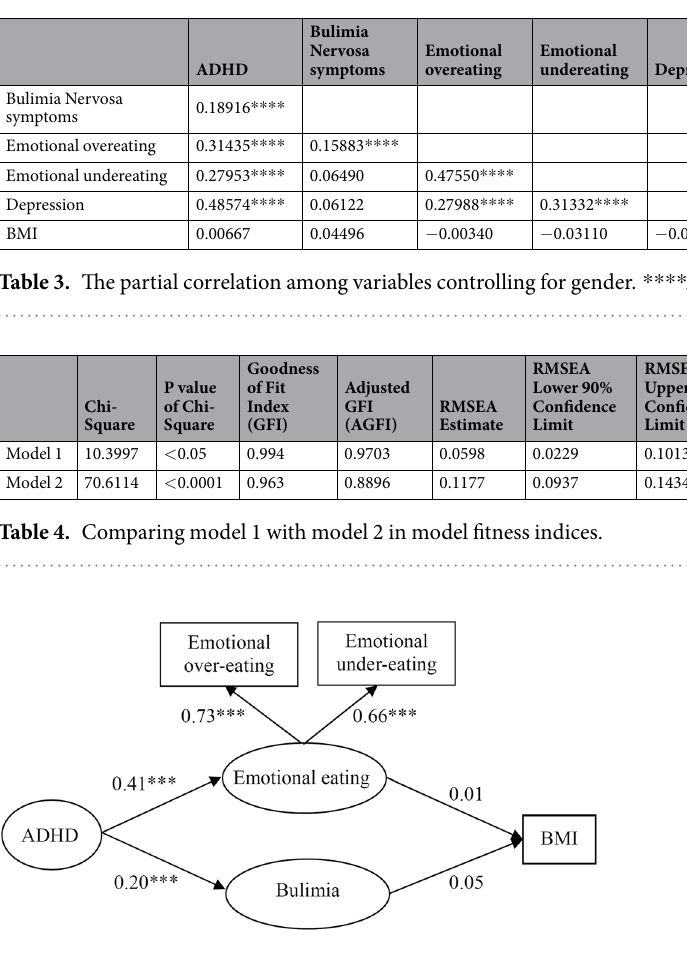
Figure 1. SEM model 1 testing correlations among ADHD symptoms, emotional eating, bulimia and BMI in children.